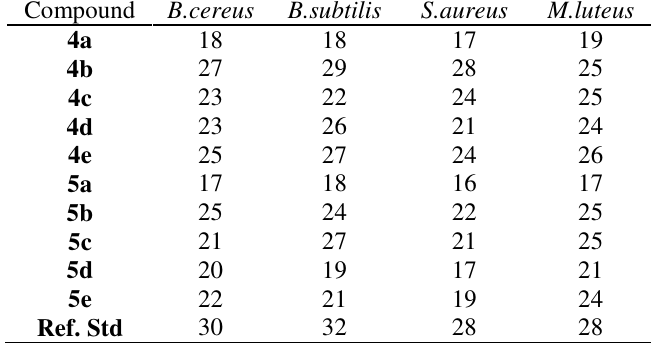
Table 2. Antibacterial activity of compounds ( 4a-e) and (5a-e) (zone inhibition in